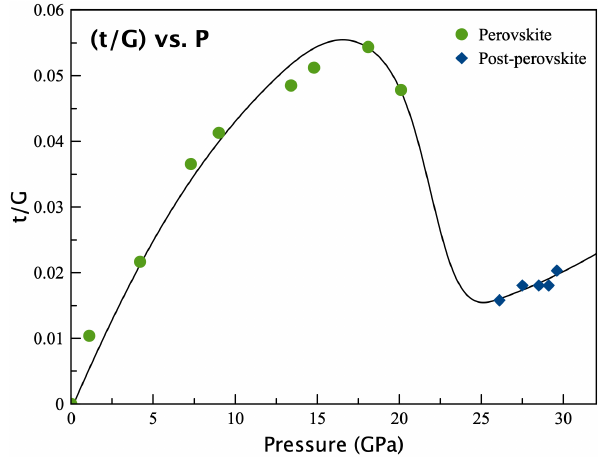
Figure 3. Unit cell volumes of NaCoF 3 perovskite and post- perovskite plotted vs. pressure. Lines are second-order Birch– Murnaghan equation of state, fit for each phase assuming constant temperature and used to illustrate compression behavior vs. experi- mental values.